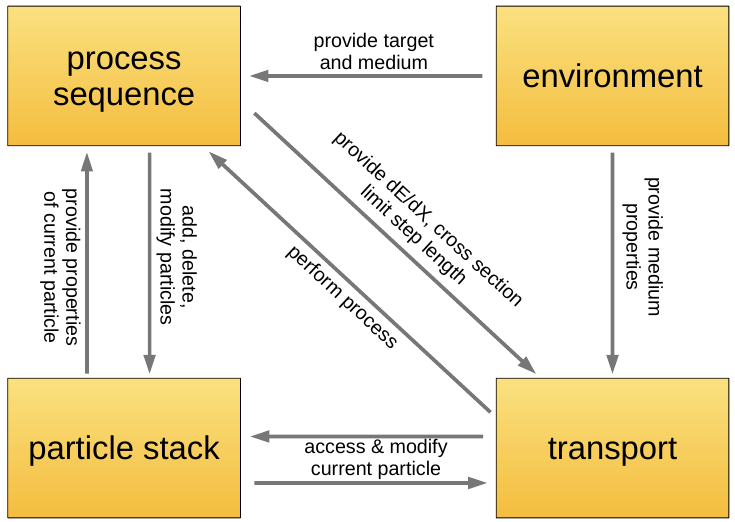
Figure 1. Main building blocks of CORSIKA 8. The relationships and dependencies between the blocks are shown as arrows. Each of these major blocks is by itself a modular system of algorithms. Basically all functionality can be replaced by alternative modules / implementation in a very straightforward way. This also means future extensions can be included